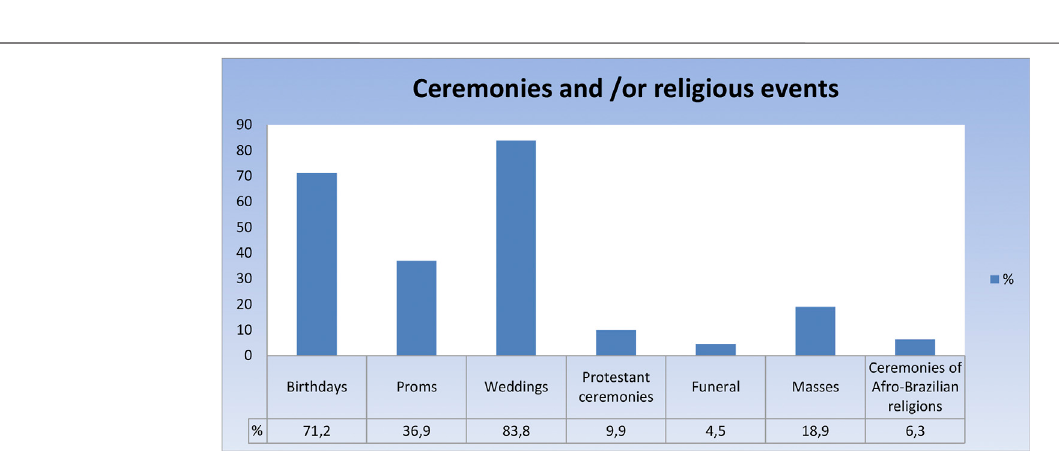
FIGURE 3 | Signi fi cance of bars and restaurants in relation to total income.